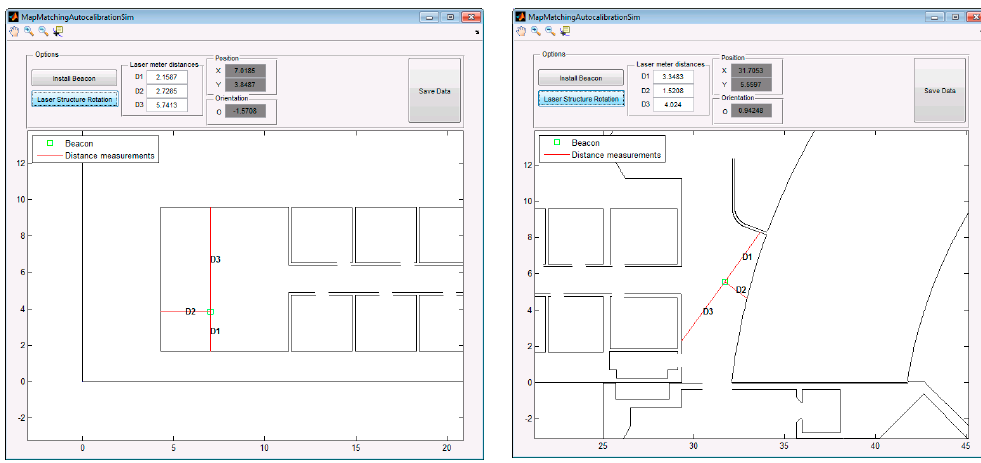
Figure 7. Simulated calibration of two beacons: beacon #1 (left) and beacon #2 (right).